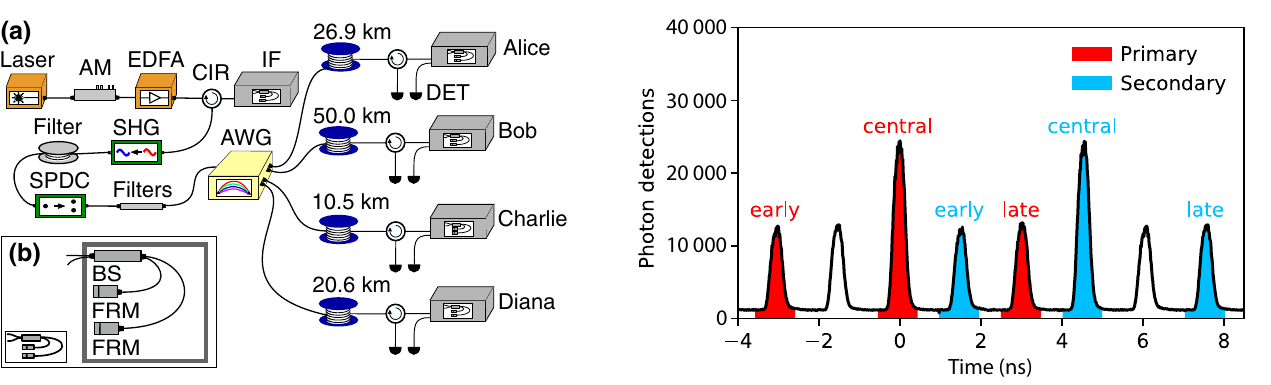
FIG. 3. The histogram of photons traveling through 10.5 km of fiber before detection at one of Charlie’s detectors. The his- togram shows the pulse interleaving. The structure of three peaks (early, central, and late) for each color is produced by the interfer- ometer time delay of 3.03 ns [cf. Fig. 1(b)]. By setting the source repetition time to 4.55 ns (corresponding to 219.78 MHz), a sec- ondary triplet of time bins (blue) is interleaved with the primary triplet (red). The data are accumulated over 90 s. Although the peaks in the detection histogram are broader than the laser pulses of the photon source due to chromatic dispersion and detector timing jitter, they are sufficiently separated to avoid overlap, so that the QBER is kept